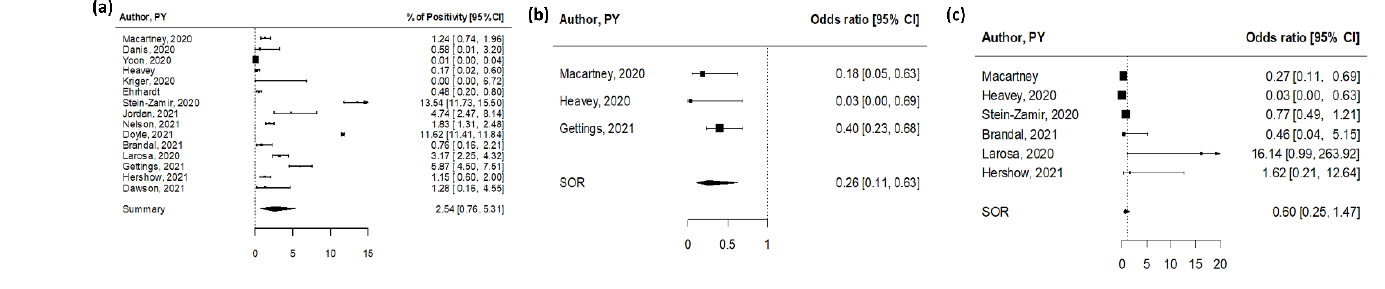
Figure 4. Pooled estimates for contact tracing studies [16,41–54]. ( a ) Pooled estimate of testing positive for SARS-CoV-2 after a contact with a case in the school setting. ( b ) Summary OR of testing positive for SARS-CoV-2 after a contact with a young versus an adult case in the school setting. ( c ) Summary OR of testing positive for SARS-CoV-2 in young versus adults after a contact with a case.